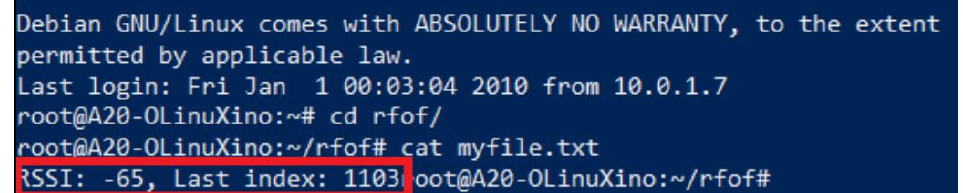
Figure 10. The content of log